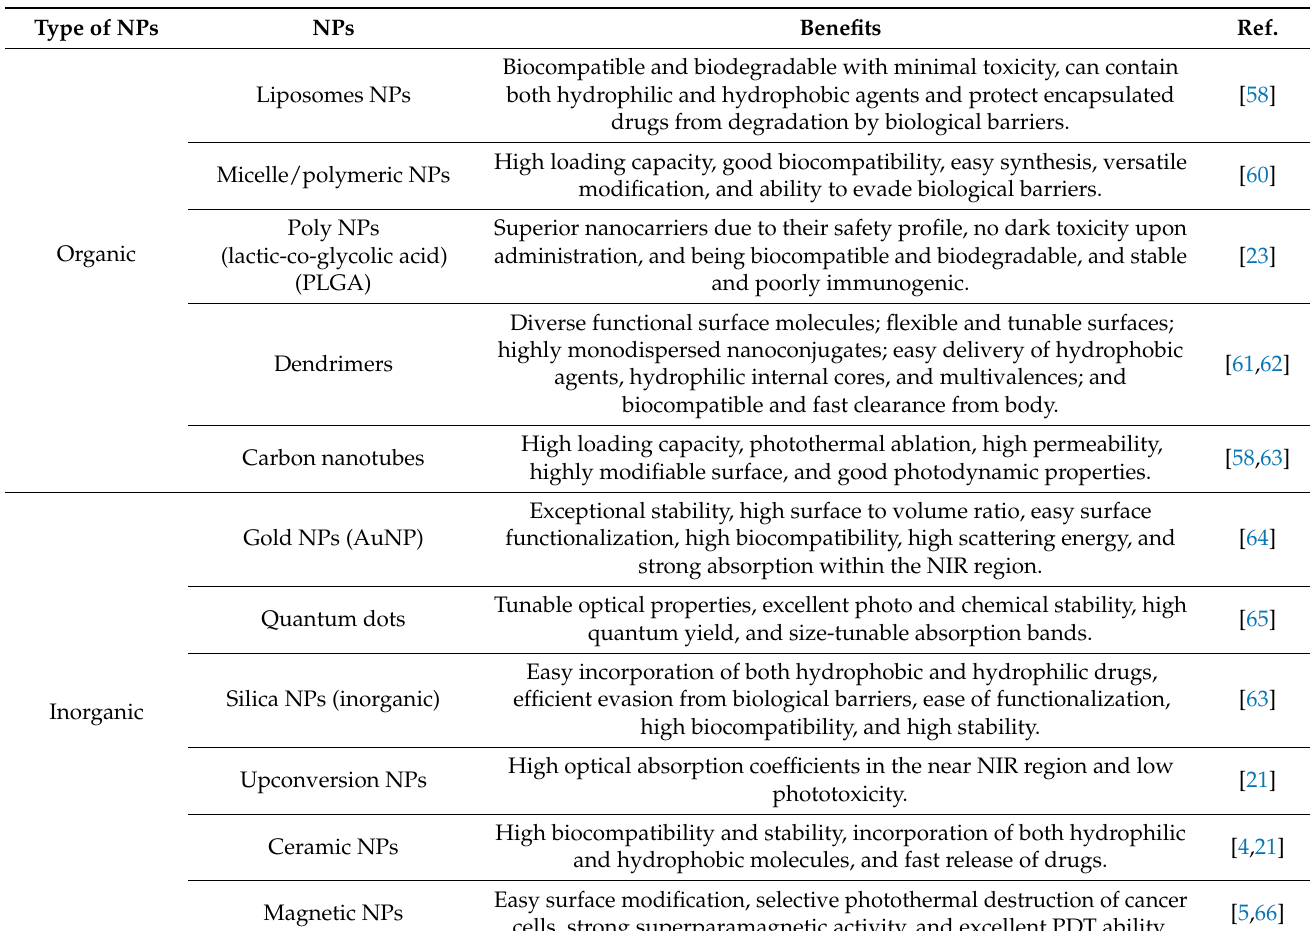
Table 2. Various organic and inorganic NPs used for smart drug delivery in PDT and their benefits. Type of NPs NPs Benefits Ref. Liposomes